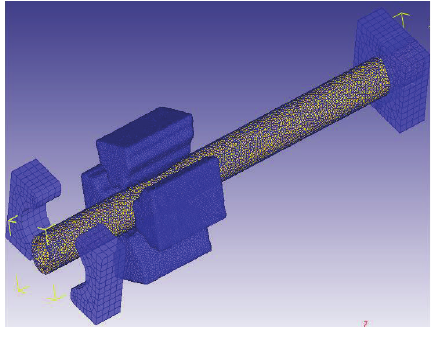
Figure 2: Finite element